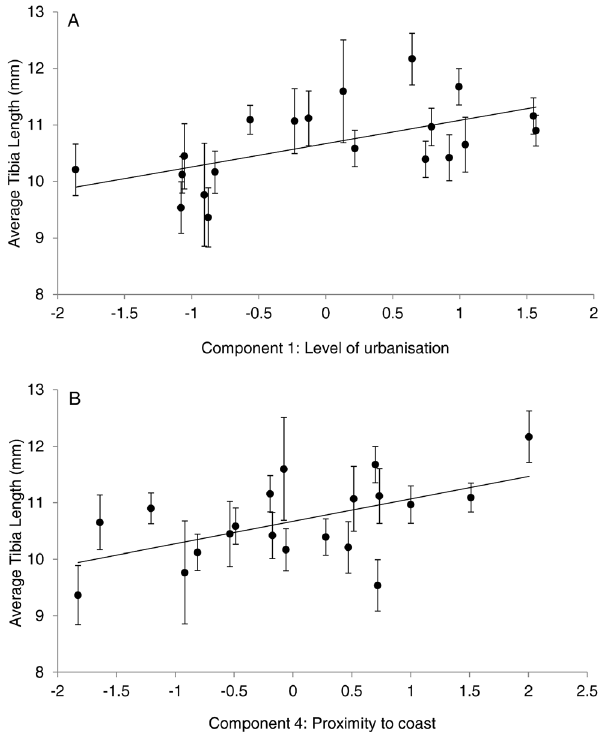
Figure 1. Relationships (site average + / 2 S.E) between the factorials of landscape scale components and spider size. a) Positive correlation between average tibia length and landscape component 1: positive association with hard surface land cover, housing density, distance to bush land and population density and a negative association with vegetation land cover and distance to CBD, (n=20, r 2 =0.33, p , 0.01). b) Positive correlation between average tibia length and landscape component 4: positive association with percentage water cover and negative association with distance to the coastline (n=20, r 2 =0.30,